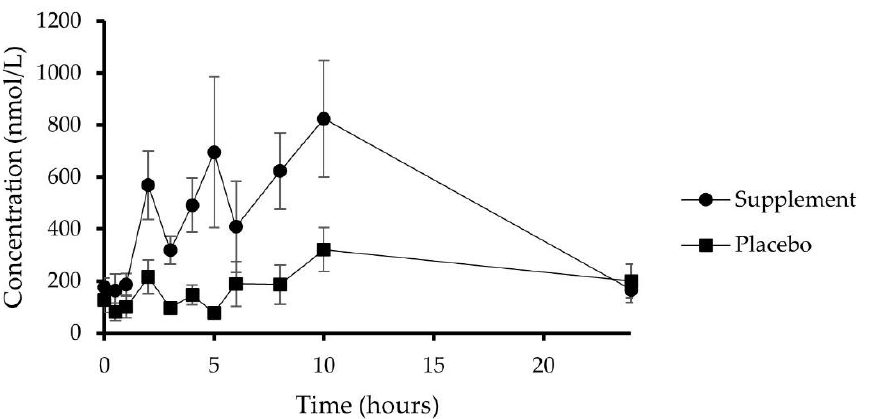
Figure 4. Sum of all (poly)phenol metabolites detected in plasma in placebo ( n = 10) and supple- mented subjects ( n = 10) over a 24 h period. Data are expressed as means ± SEM.